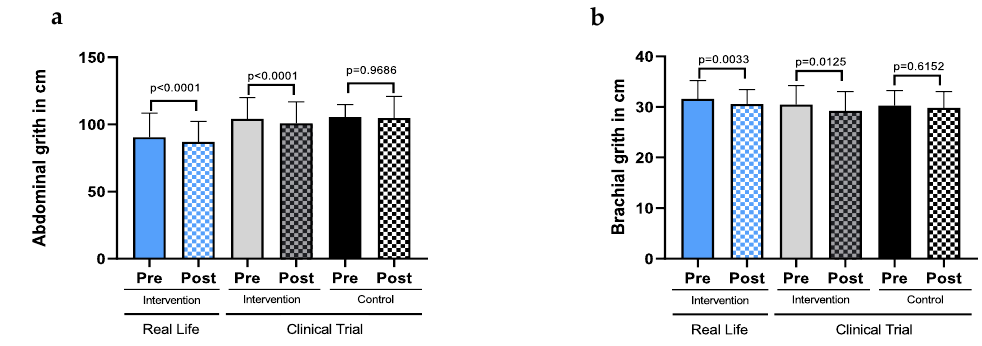
Figure A2. Abdominal and brachial girths in old individuals before and after a six-month intervention. ( a ) Abdominal girth. ( b ) Brachial girth. Real-Life Intervention n = 50, Clinical Trial Intervention n = 51, Clinical Trial Control n = 49. Bars represent mean ± SD. Statistical analysis was performed with the Student’s t test for paired samples and the Wilcoxon test for non-parametric